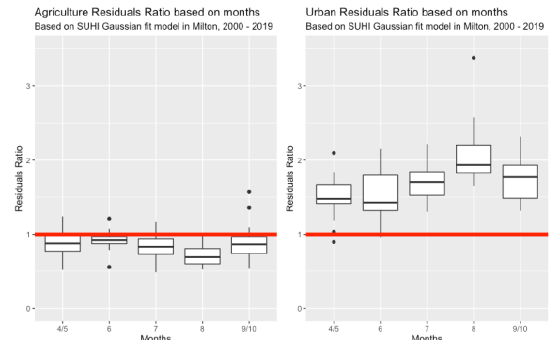
Figure 5 . The residuals ratio for agriculture and urban land covers determined by dividing the number of positive residuals by negative residuals within each captured Landsat 7 ETM+ product.